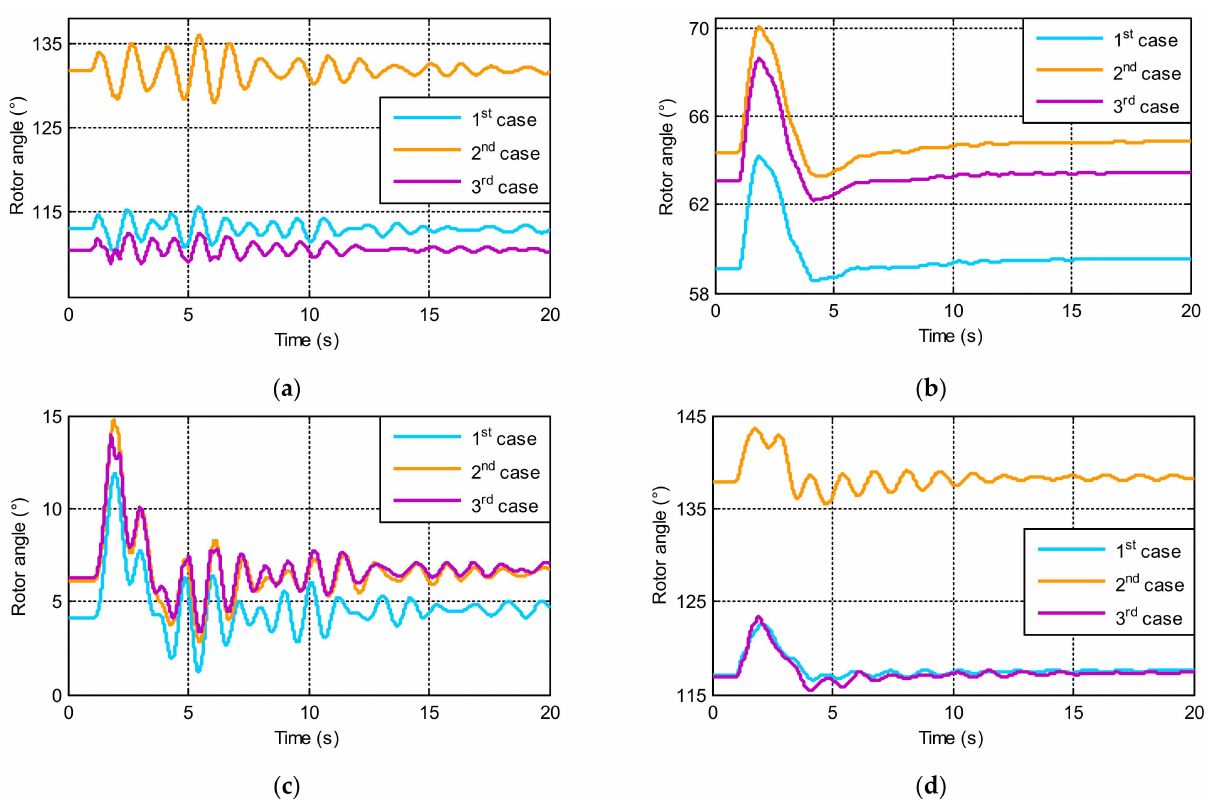
Figure 9. Transient response of the Iraqi super grid against a bus disturbance for studied test cases: ( a ) spread angle; ( b ) average angle; ( c ) smallest angle; ( d ) largest